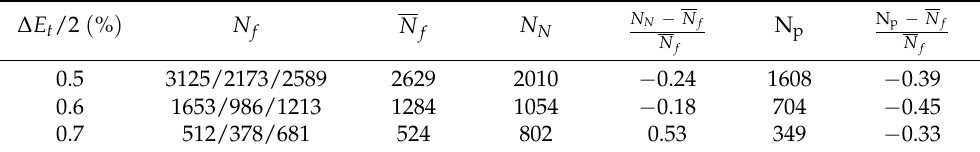
Figure 18. Comparisons between the experiments, predicted results using the proposed method under different probability combinations, and a previously published method based on the crystal plasticity (CP) theory. Table 5. Tested LCF lives of the UFG AA6061 vs. the predicted results considering only one FIP. t E 2(%) Δ